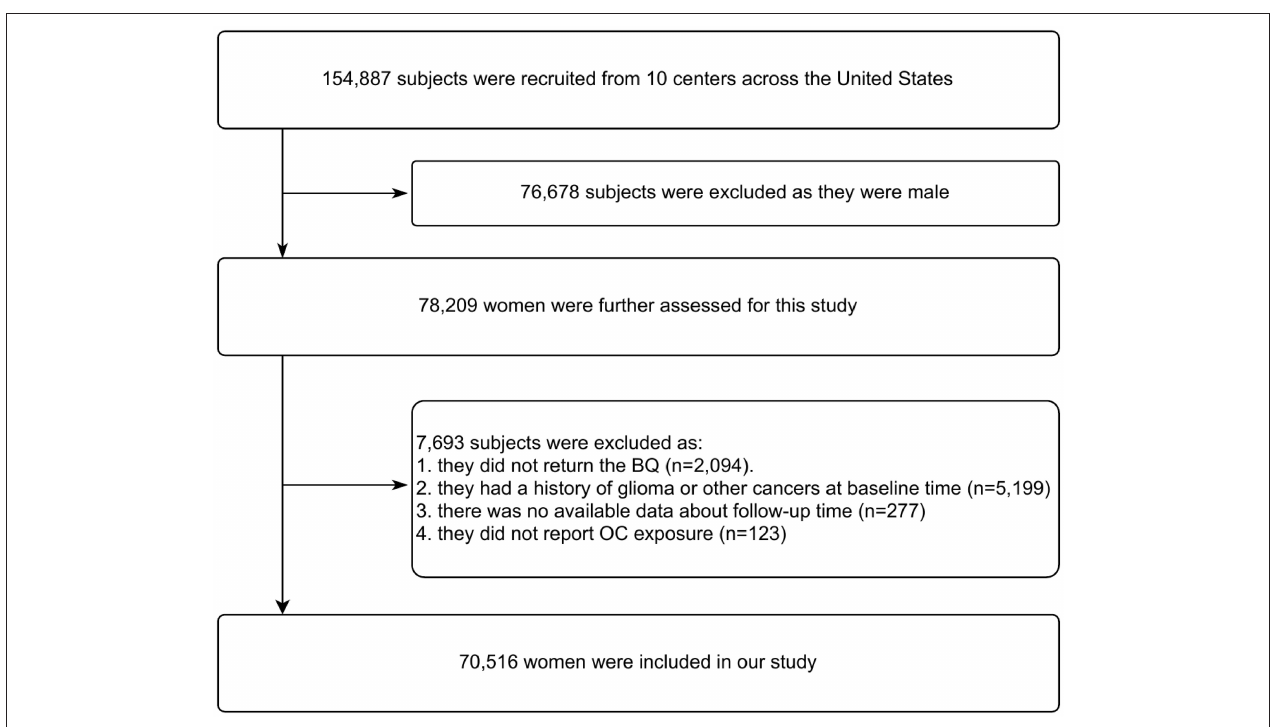
FIGURE 1 | Flowchart of identifying subjects. BQ, baseline questionnaire; OC, oral